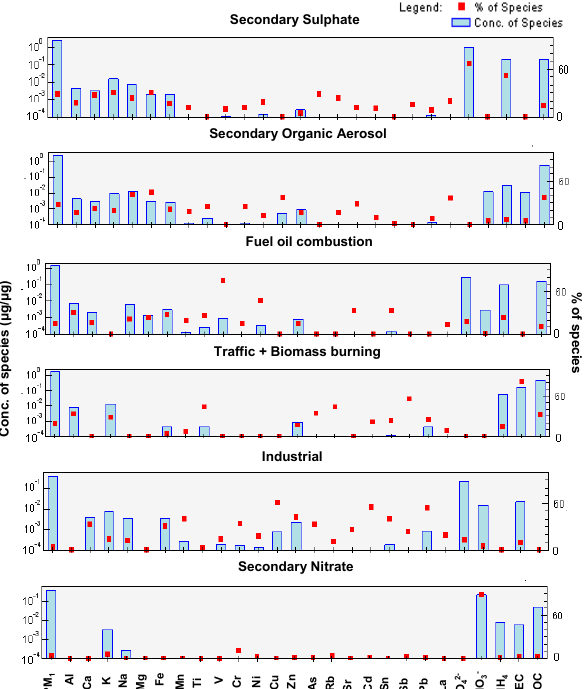
Fig. 2. Source profiles (µg/µg) identified for PM 1 measured at MSY. All available PM 1 samples (182) were used. The mass of each species apportioned to the factor (blue bar, left axis) and the per- cent of each species apportioned to each factor (red square, right axis) is shown.